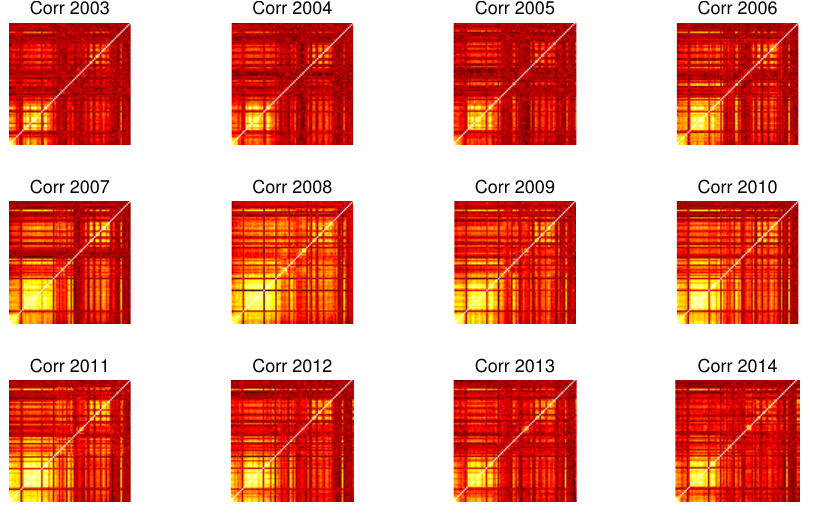
Figure 7. Correlation matrices for each of the years of data for Sector 1 (original × original variables). Brighter colors denote higher correlation, and darker colors denote lower correlations.